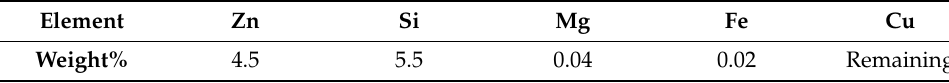
Table 1. Elemental composition of silicon-brass Copper (C87600) alloy.